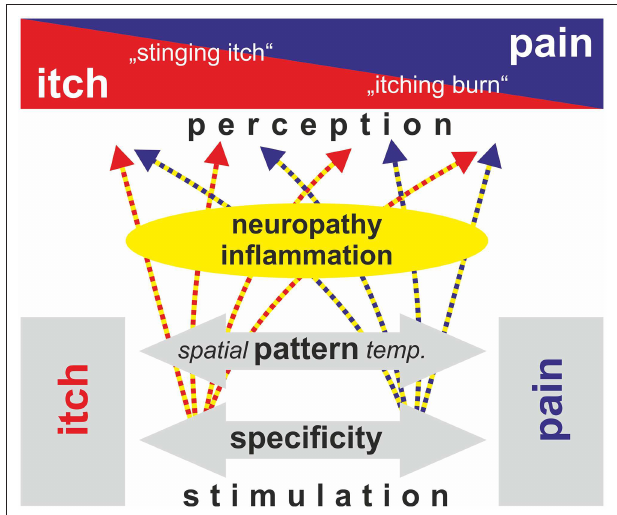
FIGURE 2 | Schematic view of mechanisms that have been proposed to explain the generation of an itch (specificity, pattern, intensity; black and